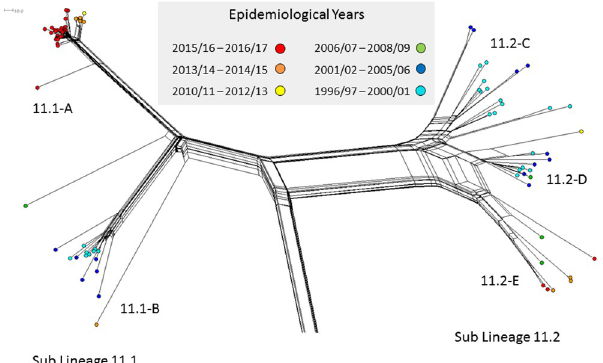
Fig 4. cgMLST NeighbourNet diagram of cc11MenC isolates from disease cases (n = 74, 1997–2017) and nasopharyngeal carriage (n = 28, 2016/17) in the RoI. Colours indicate different periods of isolation. Scale bar represents a pairwise allelic difference of